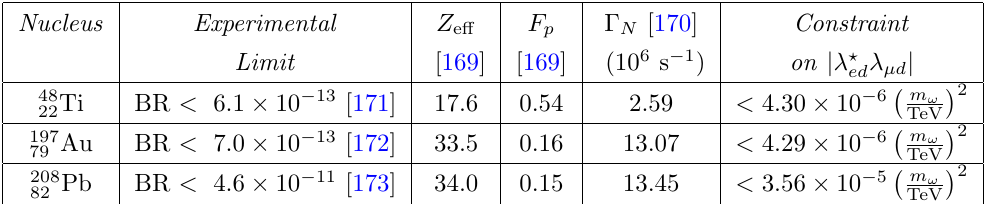
e conversion in di(cid:11)erent (cid:0)